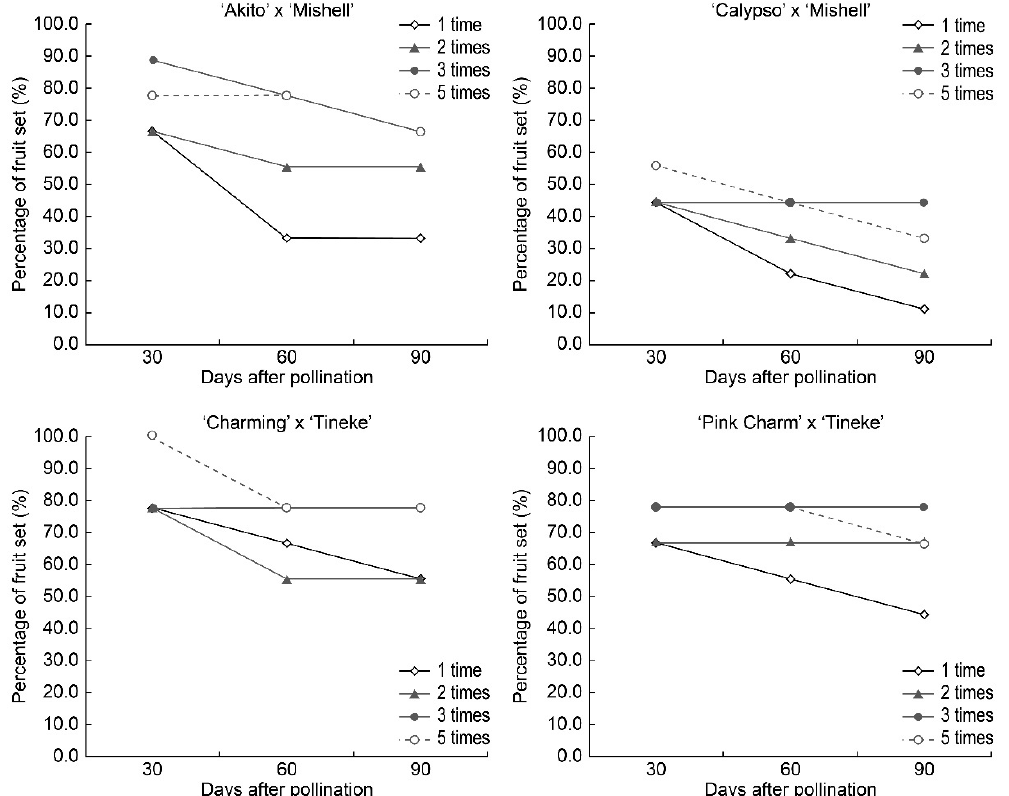
Figure 6. Effect of repeated pollination on fruit set percentage after 30, 60, and 90 days in two com- binations of standard and spray types. combinations of standard and spray